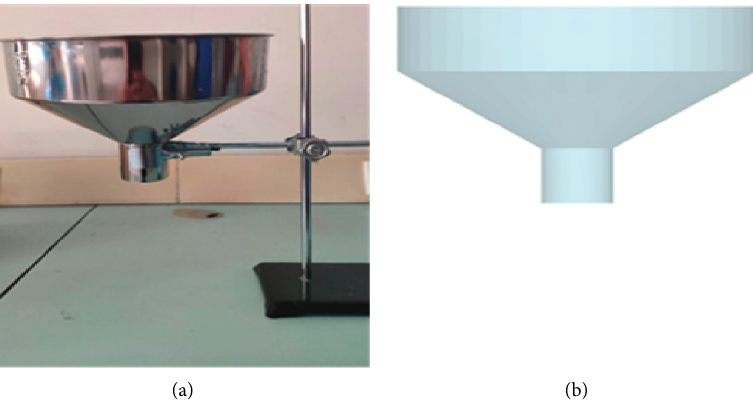
Figure 2: Test device. (a) Field test device (b) simulation test device.